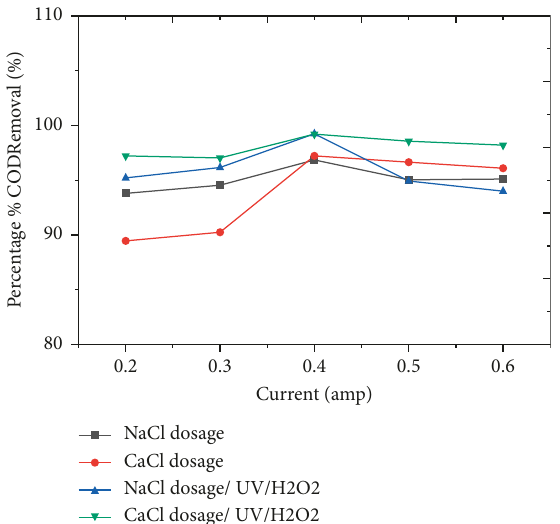
Figure 2: Effect of pH on removal efficiency COD from coffee processing wastewater.